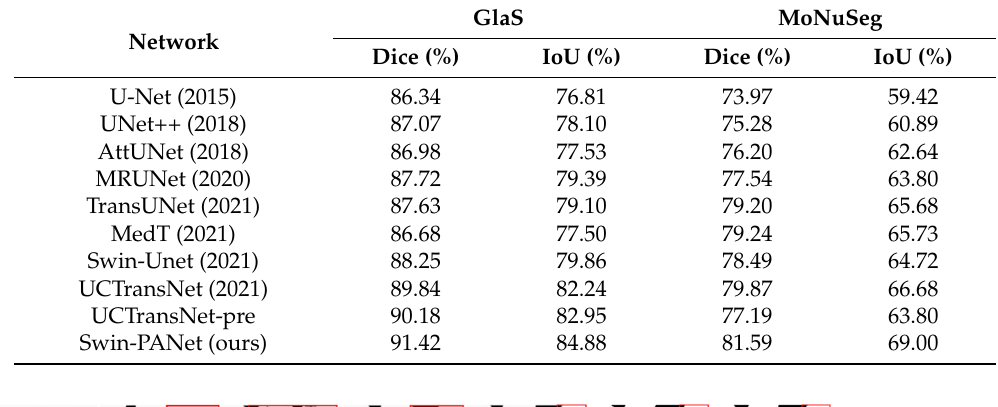
Table 1. The quantitative comparison on GlaS and MoNuSeg datasets implemented on state-of-the-art methods. For simplicity, AttUNet and MRUNet denote the above methods: Attention U-Net and MultiReUNet. UCTransNet-pre denotes UCTransNet based on pre-training.